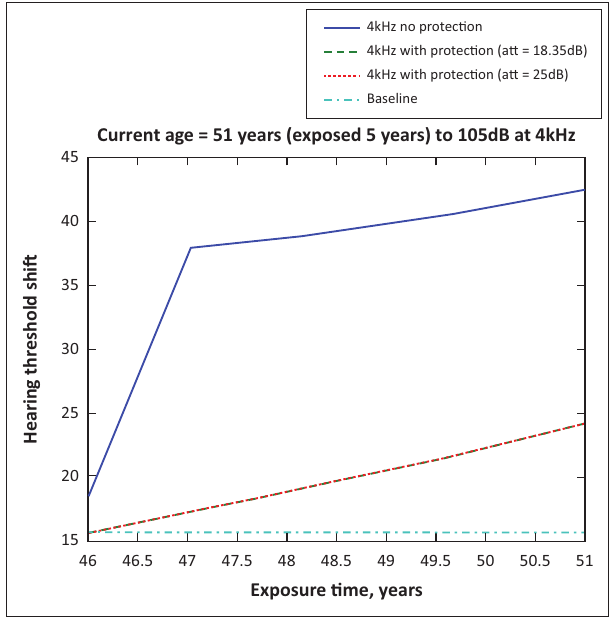
Source : Figure created using data from Moroe, N.F. (2018). Occupational noise-induced hearing loss in South African large scale mines: From policy formulation to implementation and monitoring . Doctoral thesis. Johannesburg: University of the Witwatersrand. FIGURE 11: Fifty-five years old at 3000 Hz with exposure levels of 110